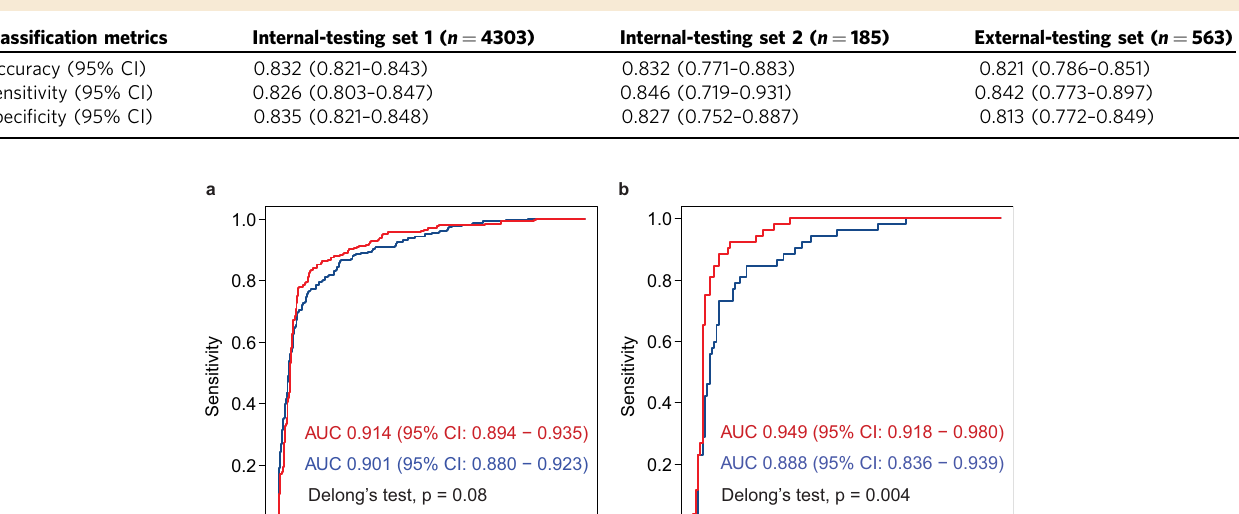
Table 2 Classi fi cation metrics of HTNet with ultrasound images as input.